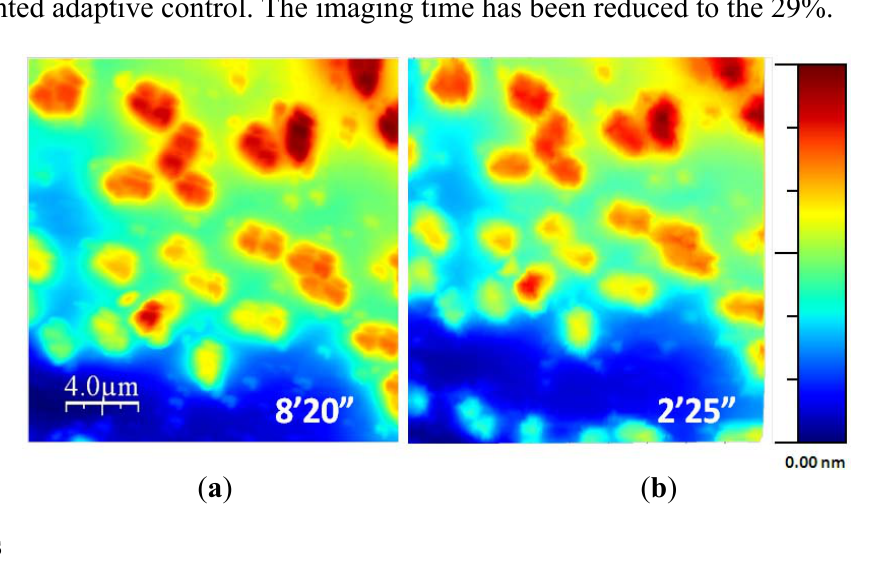
Figure 12. ( a ) Escherichia coli bacteria imaged with a standard technique, and ( b ) the implemented adaptive control. The imaging time has been reduced to the